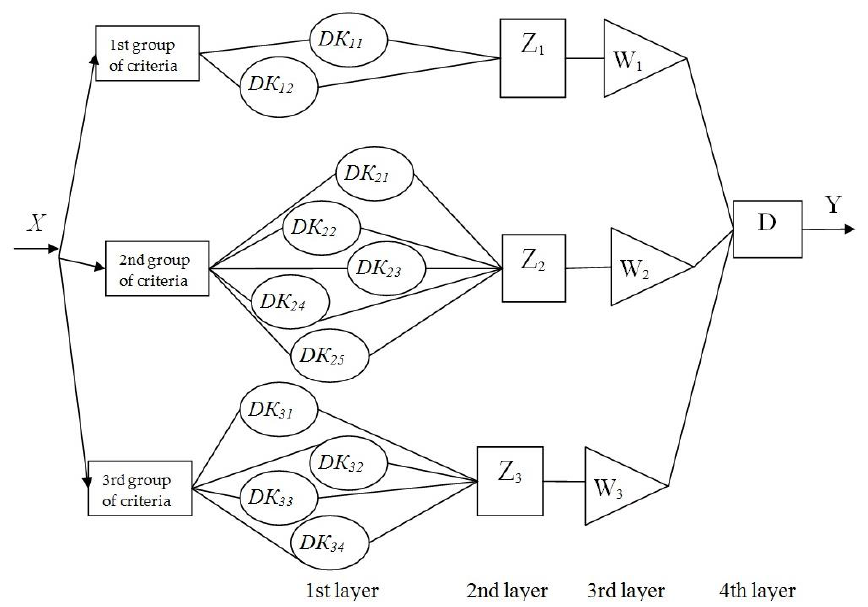
Figure 2. The structure of the neuro-fuzzy network of the team environmental start-up project for air transport.